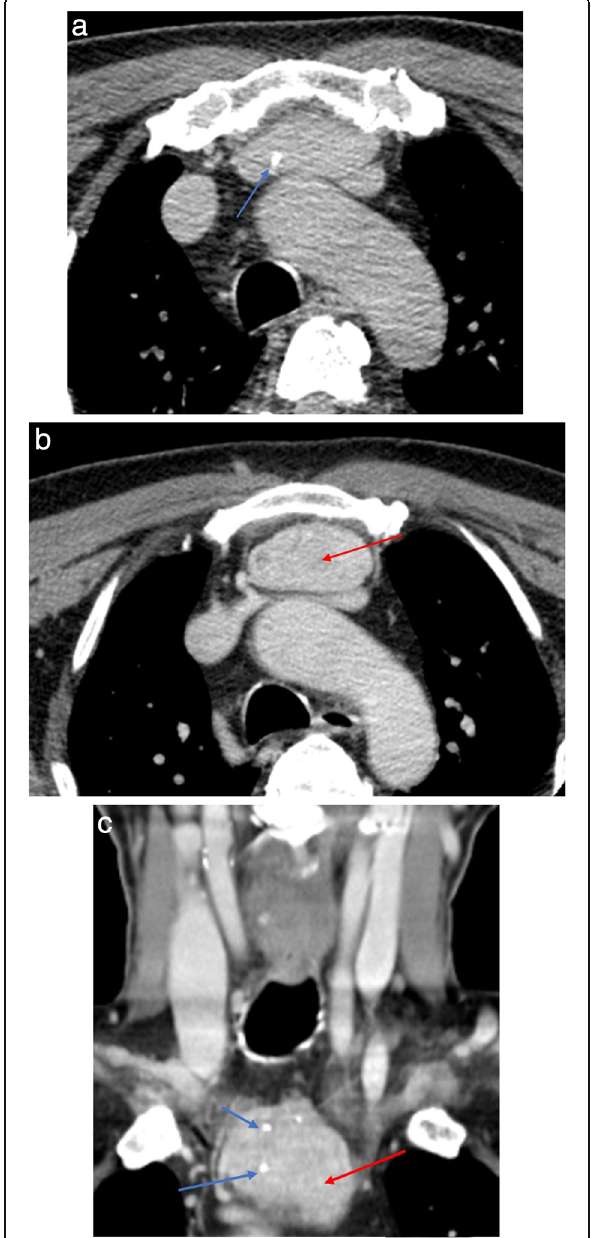
Fig. 1 Axial CT scan before ev contrast ( a ); axial ( b ) and coronal ( c ) CT scan after ev contrast demonstrating homogeneously enhancing tissue (red arrow), showing some microcalcifications (blue arrows), at the level of the anterior mediastinum, at pre-vascular